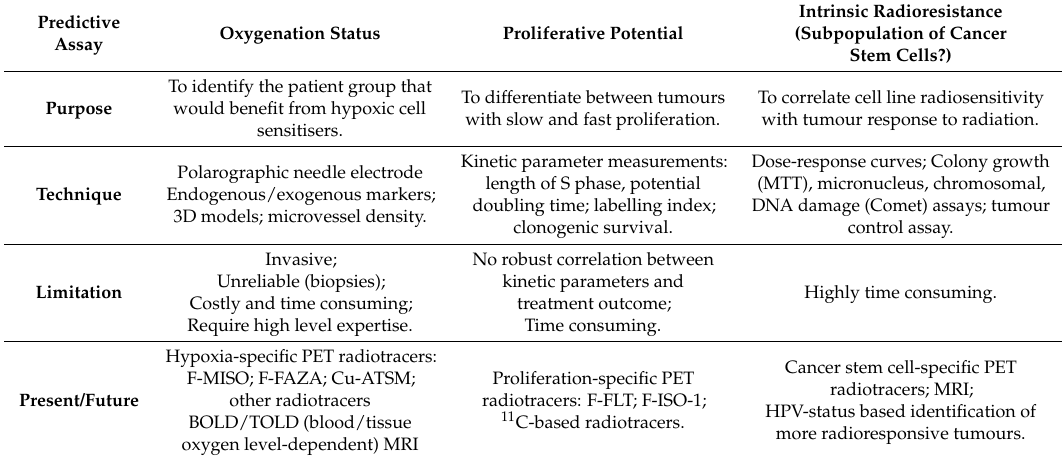
Table 1. Predictive assays for tumour response to radiotherapy and their limitations (modified from [5]). Predictive